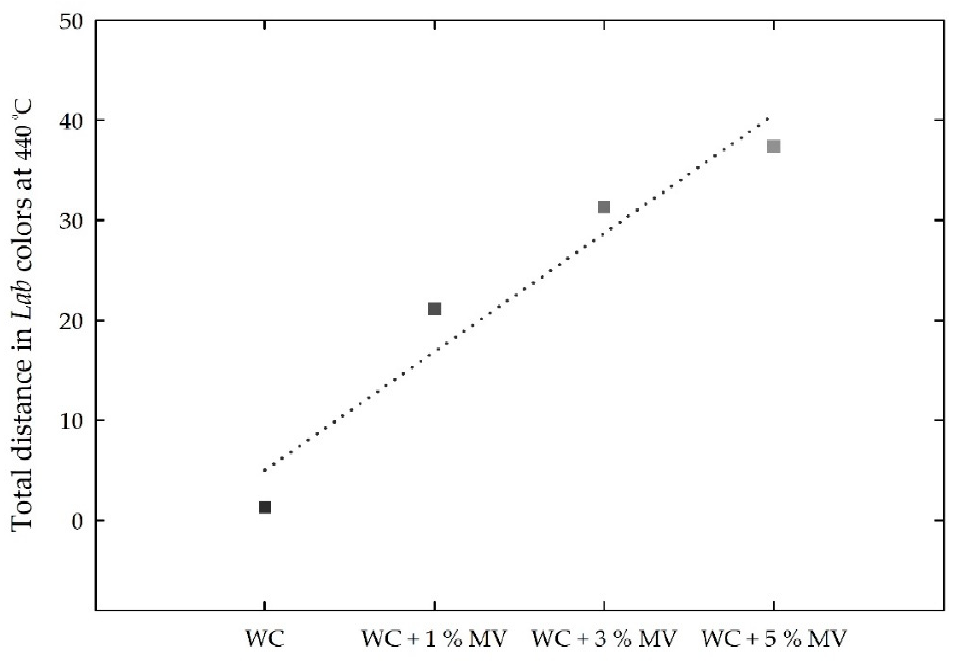
Figure 16. Total distance in the Lab intensities for the white cement (WC) mixed samples with increasing MV pigment content at 440 ° C